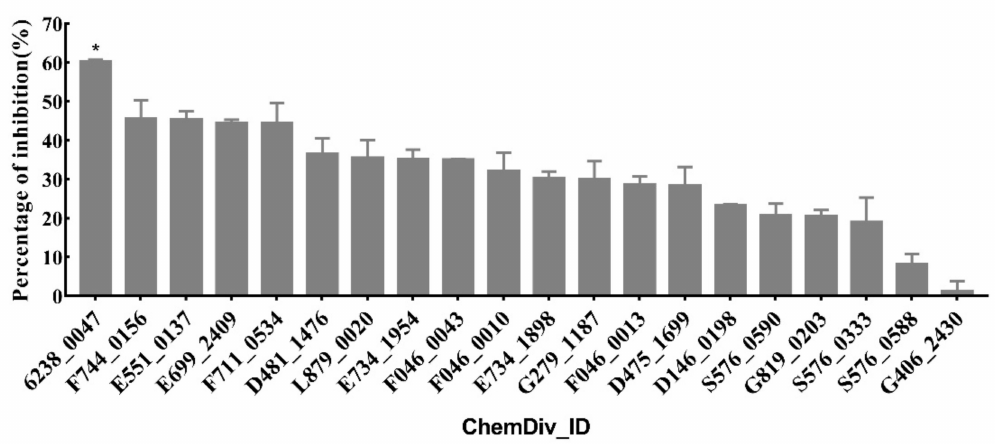
Figure 2. Percentage of inhibition of candidate compounds (0.5 mM) against ruminal microbial urease. Asterisks (*) indicate that the di ff erence between compound 6238-0047 and other candidate compounds were significant ( p < 0.05).